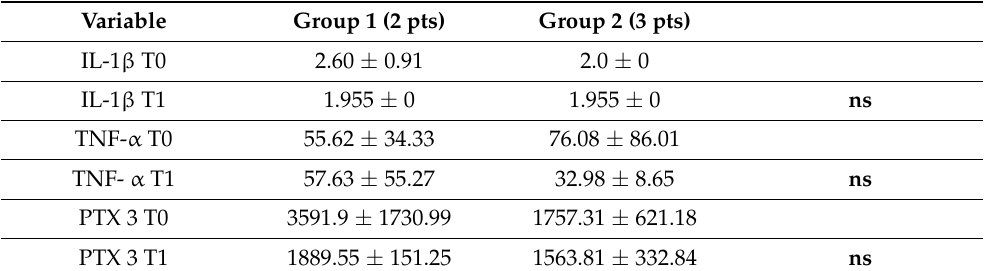
Table 6. Comparison between IL-1 β , TNF- α and PTX3 between Group 1 and Group 2. Data are shown as mean ± standard